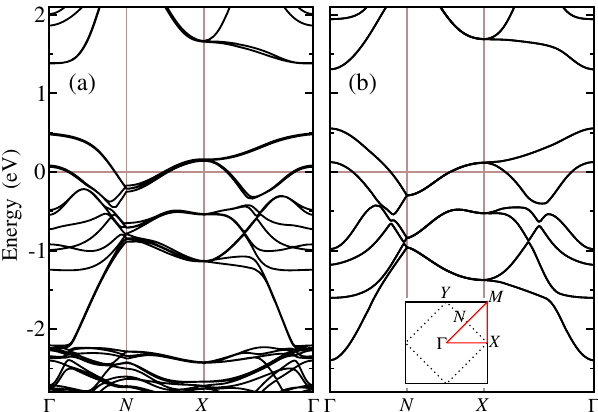
FIG. 1. Comparison of the band structures obtained using (a) LDA and (b) the five-orbital TB þ SOC model with lattice distortion caused by staggered octahedra rotation. The doubling of bands and the small band splitting in (a) is due to the doubling of unit cell along the c axis. The inset in (b) shows the one-Ir Brillouin zone (solid black lines), the reduced zone (dotted black lines), and the high-symmetry points labeled by Γ ¼ ð 0 ; 0 Þ